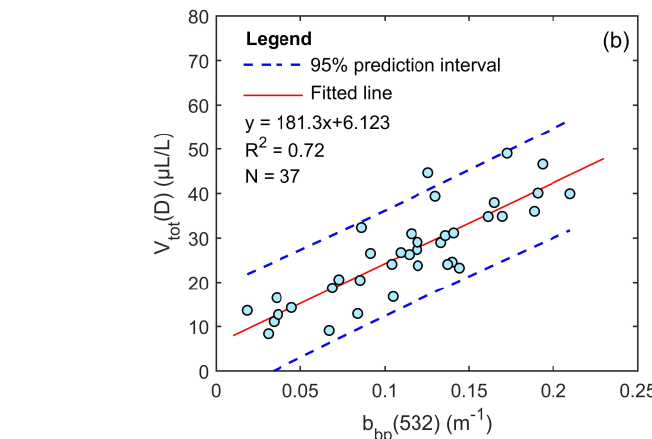
Figure 4. The V tot (D) estimation from ( a ) b p (532) and ( b ) b bp (532). For D v50 retrieval, 23 simultaneous b p *(λ), b bp *(λ) , and D v50 datasets were used in the calibration of the inverse proportion model (Figure 5a for b p *(λ) and Figure 5b for b bp *(λ)), negative power function model ((Figure 5c for b p *(λ) and Figure 5d for b bp *(λ))), and negative exponential function model (Figure 5e for b p *(λ) and Figure 5f for b bp *(λ)). The results for all models are shown in Table 3. Overall, a good fit (R 2 = 0.85, RMSE = 33.5 µ m) was found by the proposed model for the relationship between b p *( λ ) and D v50 (Figure 5e). The proposed model also showed the potential (R 2 = 0.78, RMSE = 41.3 µ m) in the relationship between b bp *( λ ) and D v50 (Figure 5f), while the other two models obtained poorer